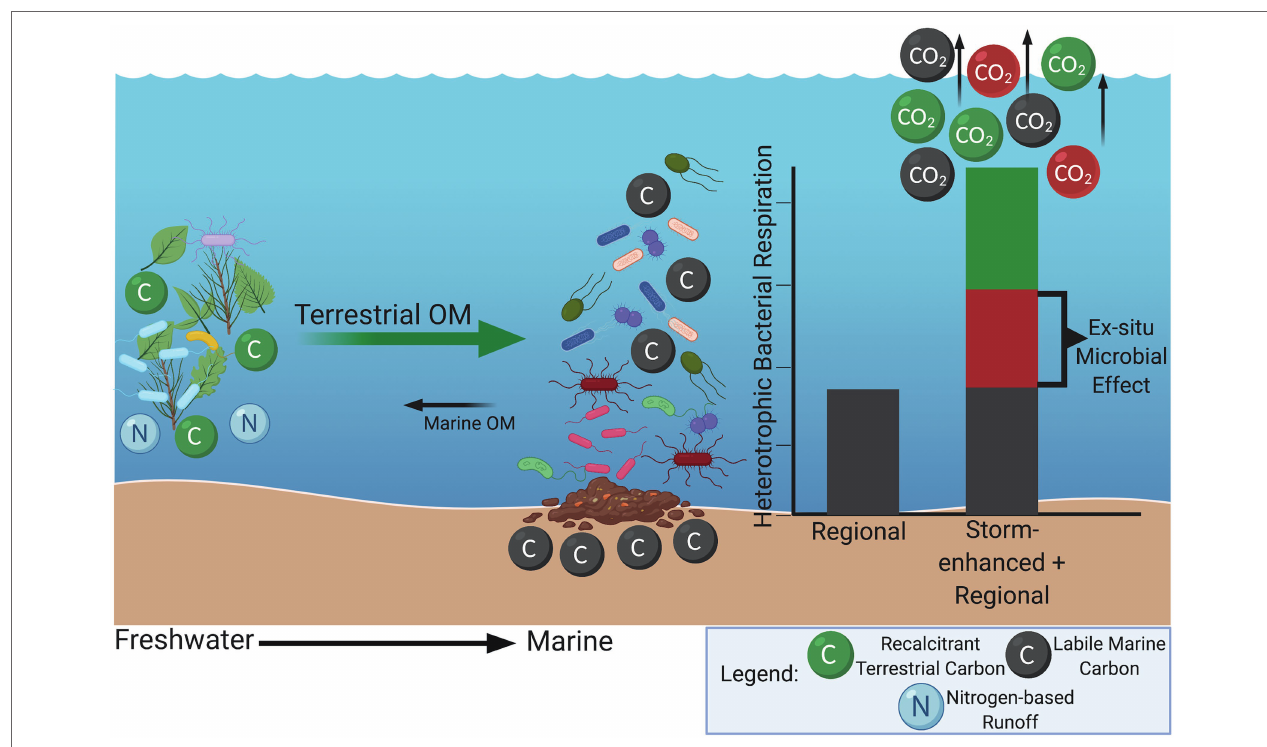
FIGURE 1 | Depiction of storm-enhanced microbial production at the interface of terrestrial and marine systems. Input of recalcitrant, high-molecular-weight plant material, terrestrial microbes, and nitrogen-based runoff into labile marine systems increases microbial biomass and production of extracellular enzymes allowing enhanced breakdown of recalcitrant material. This additive effect of higher bacterial production and respiration can be referred to as the “ ex-situ microbial effect” as seen in red on the bar graph. Green portion of the bar graph represents contribution from terrestrial heterotrophic respiration. Created with